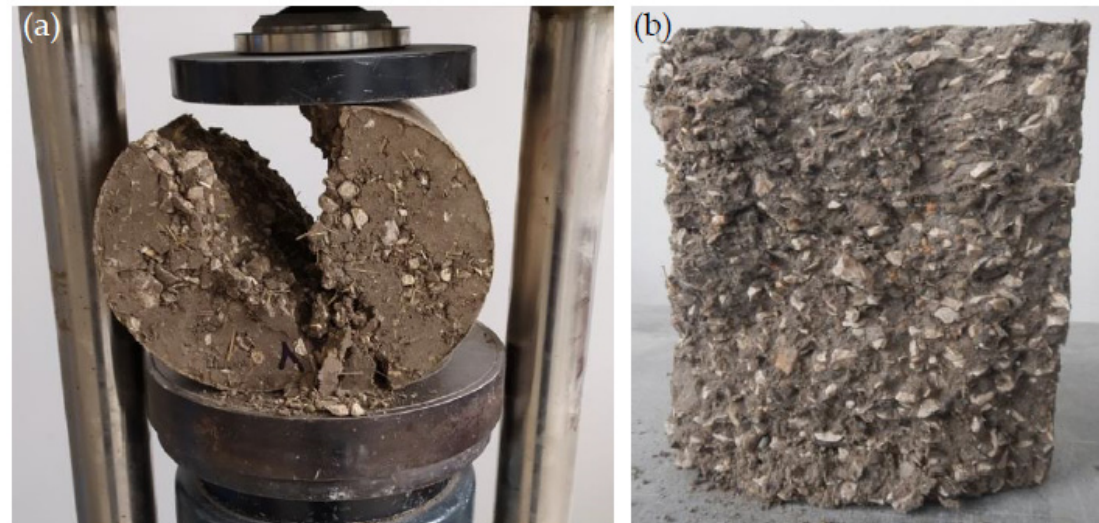
Figure 10. Failure of specimens during the indirect tensile test: top view ( a ); and transversal view ( b ).